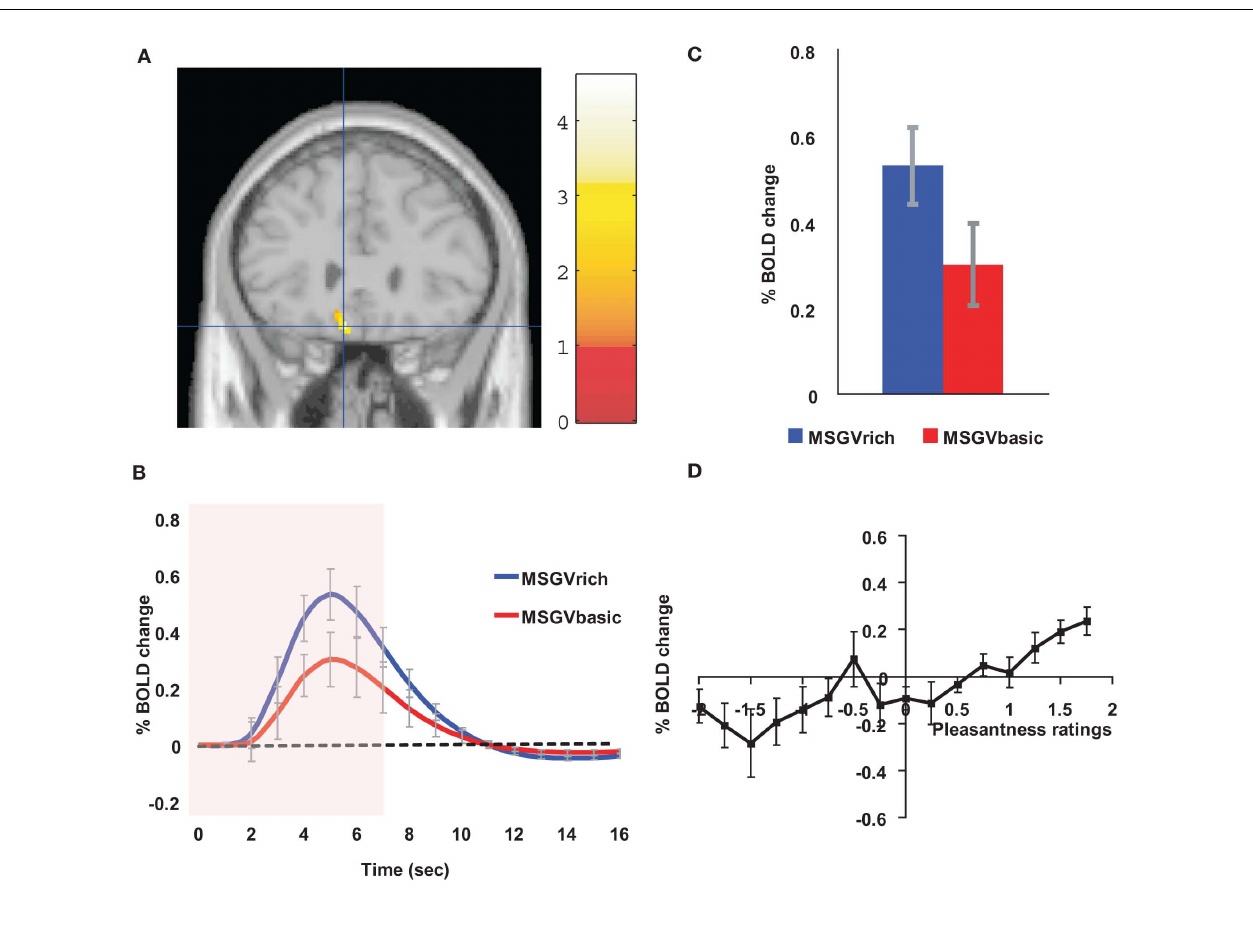
FIGURE 7 | Cognitive modulation of flavor reward processing in the brain. (A) The medial orbitofrontal cortex was more strongly activated when a flavor stimulus was labeled “rich and delicious flavor” (MSGVrich) than when it was labeled “boiled vegetable water” (MSGVbasic) ([ − 8 28 − 20]). (The flavor stimulus, MSGV, was the taste 0.1M MSG + 0.005M inosine 5 (cid:2) -monophosphate combined with a consonant 0.4% vegetable odor.) (B) The